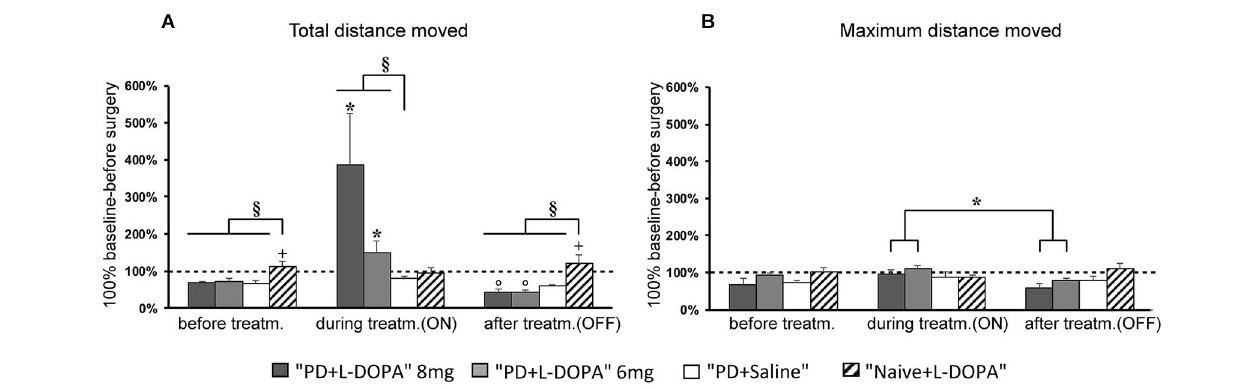
FIGURE 2 | Horizontal motor activity. (A,B) Mean of percentage values ( ± S.E.M.) of the total distance moved and maximum distance moved in the several treatment phases referring to individual values (set to 100%) recorded before surgery. (A) The PD + L-DOPA 8 mg and PD + L-DOPA 6 mg groups had more intense locomotor activity in the ON phase than in the other treatment phases (* p < 0.05 vs. before treatment and OFF phase). Both PD + L-DOPA groups had a less intense motor activity in the OFF phase than in the phase before drug treatment ( ◦ p < 0.05 vs.